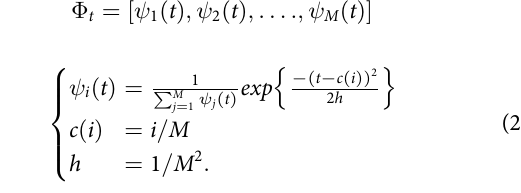
FIGURE 2 | The observed trajectories are represented in magenta. The corresponding ProMP is represented in blue. The following parameters are used: (cid:22) s = 100 for the reference number of samples, M = 5 for the number of RBFs spread over time, and h = 0.04